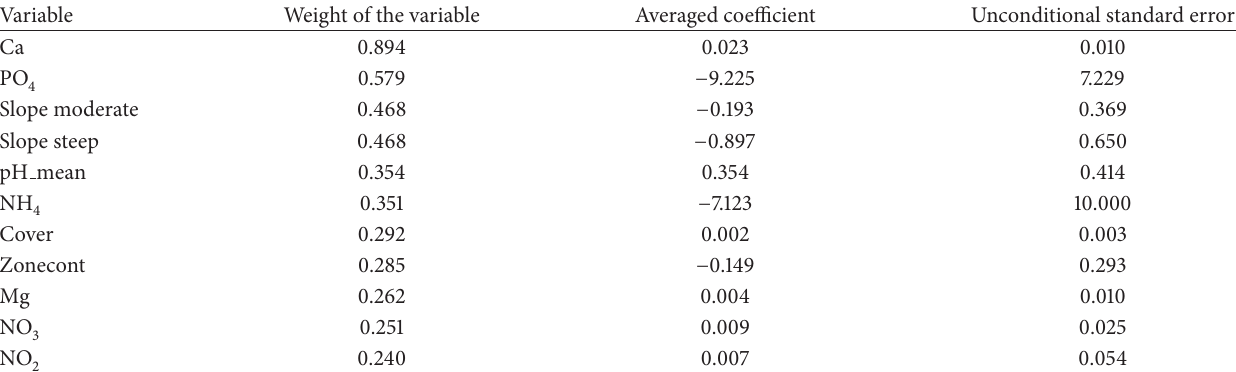
Table 8: Results of the AIC stepwise model selection for probability of presence of Brachythecium rivulare showing the best significant variables selected based on their weight.